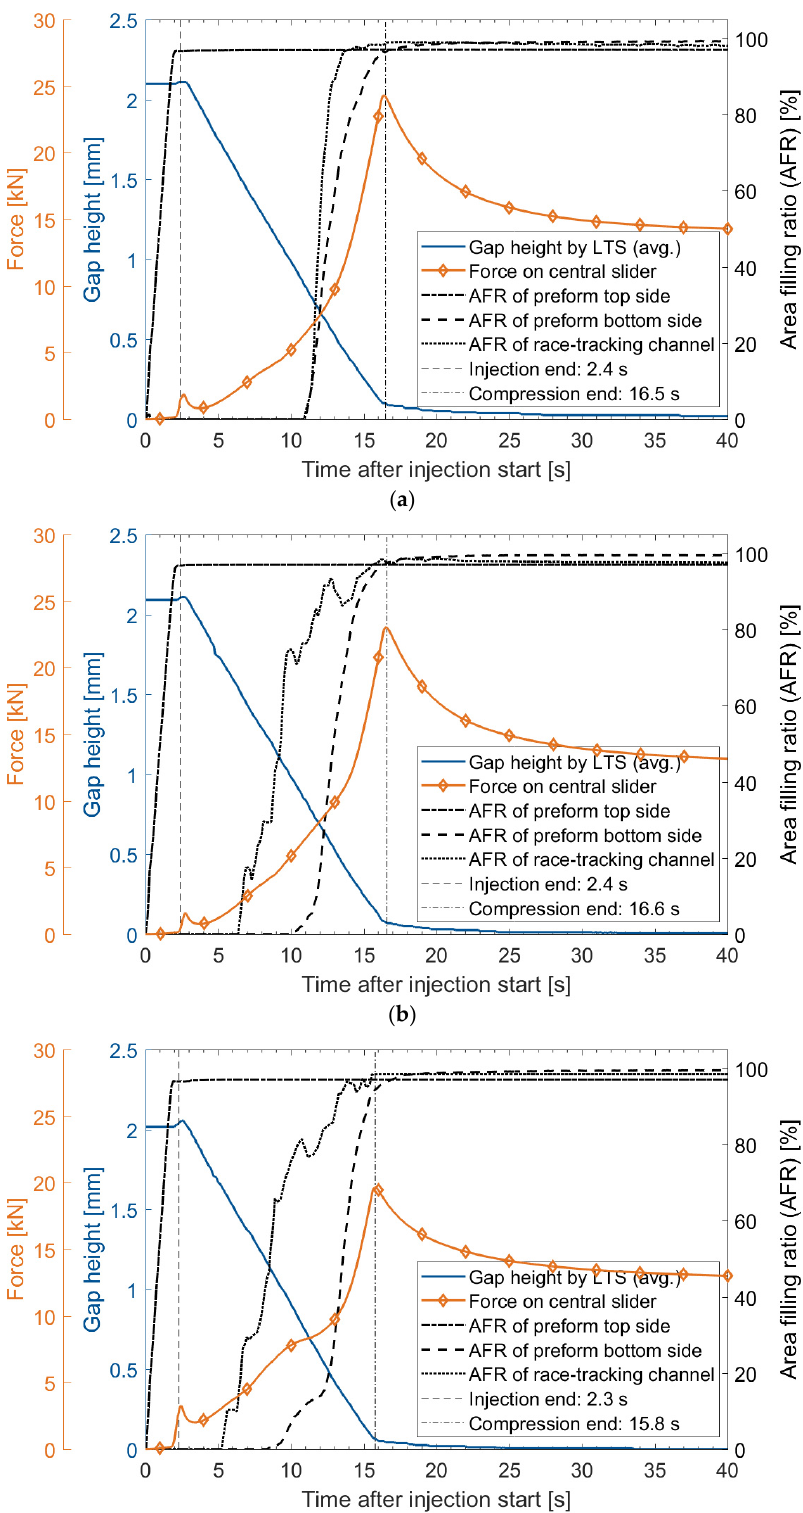
Figure A8. Overview of important process variables during FS-CRTM experiments of the flow control study: ( a ) medium race-tracking channel width—fcs-mrt-#2; ( b ) wide race-tracking channel width—fcs-wrt-#1; ( c ) wide race-tracking channel width—fcs-wrt-#3 (LTS = laser triangulation sensor).